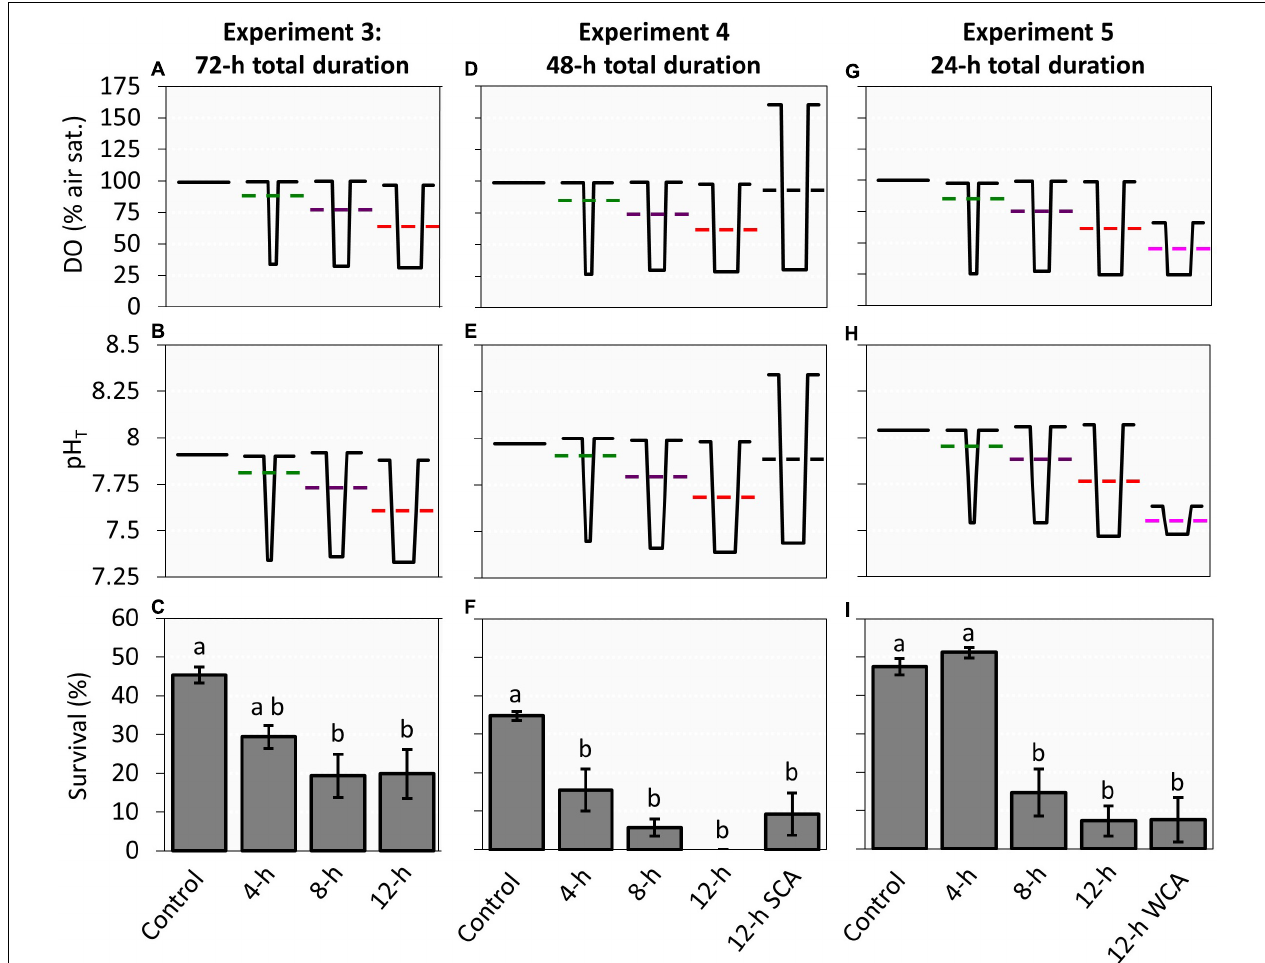
FIGURE 3 | Survival of Callinectes sapidus zoea I larvae under varying durations and amplitudes of low DO/pH diel cycling for experiments three (72-h experiment), four (48-h experiment), and five (24-h experiment). DO (A,D,G) and pH (B,E,H) values, diagrammed over a 24-h interval from the static and cycling treatments, in which dotted lines represent average values of the cycling treatments (see Supplementary Tables 3 , 5 , 6 for all chemical values and Supplementary Table 7 for daily DO and pH averages of cycling treatments across experiments). Average larval survival (C,F,I) , in which bars indicate means ( ± SE) and letters mark significant differences in survival; Captions SCA and WCA denote strong cycling amplitudes and weak cycling amplitudes,